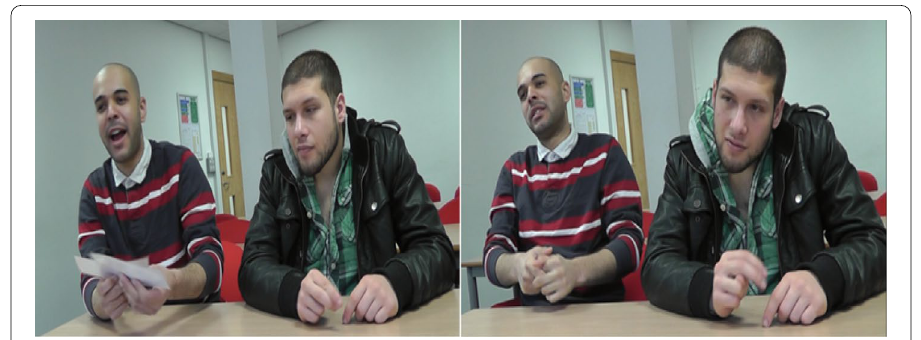
Fig. 5 Boredom in lines 7, 8 and